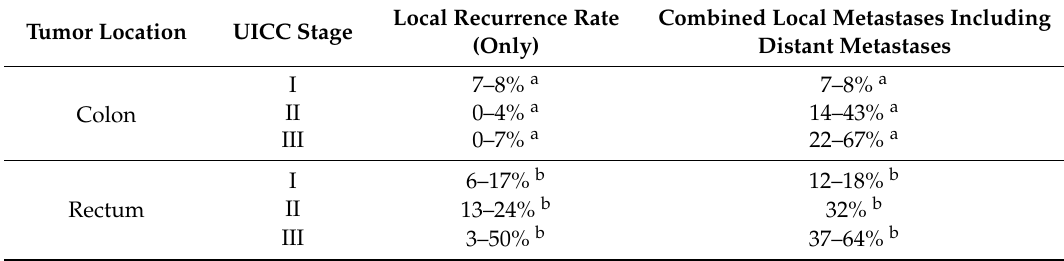
Table 6. Local recurrence rate after curative resection without multimodal therapy in colon and rectal cancer adapted from [110].